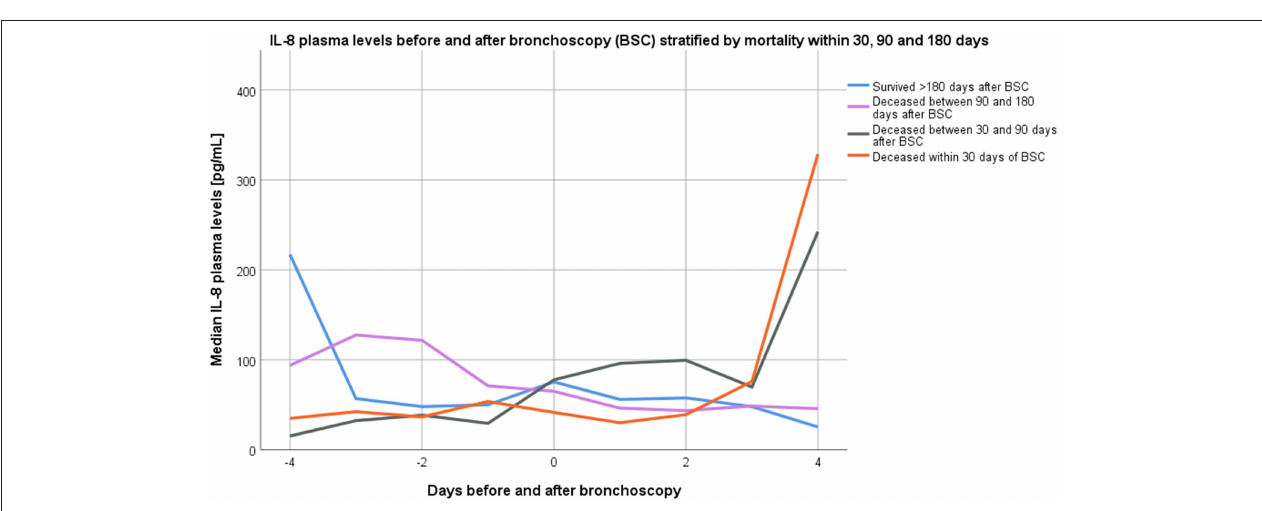
FIGURE 2 | Kinetics of median interleukin-8 plasma levels from 4 days before until 4 days after bronchoscopy stratified by overall mortality